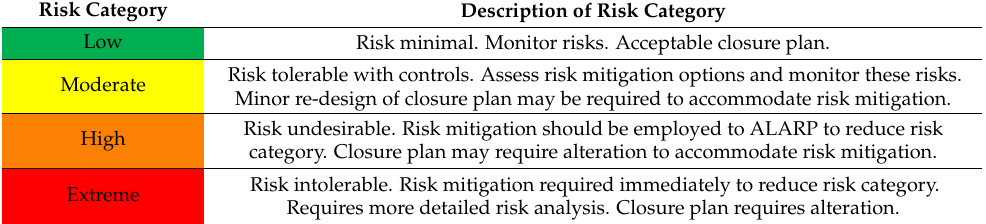
Figure 4. Risk matrix. Table 7. Risk category.